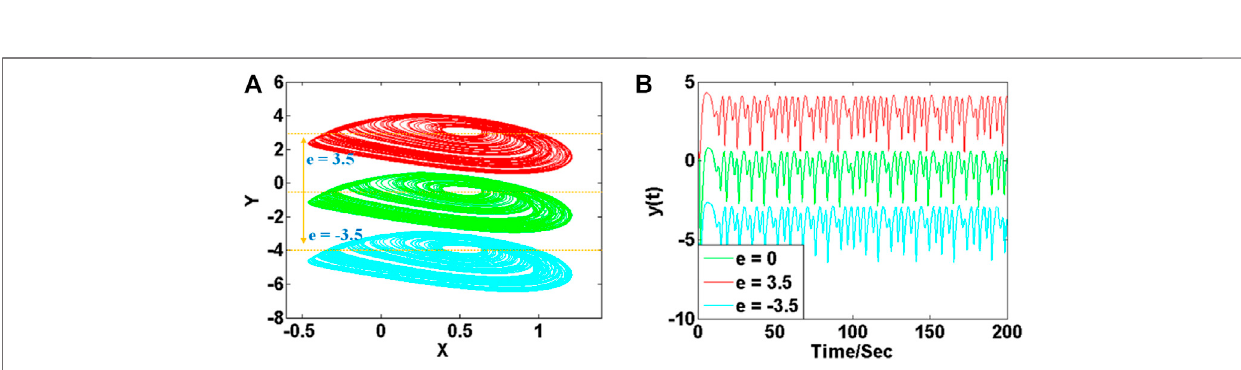
FIGURE14| Lyapunovexponentsandbifurcationofsystem(10)with a (cid:1) 2.8, b (cid:1) 5.5, c (cid:1) 1.7andtheinitialconditionsare(0,0,0)whenthememristorparameter d varies in [1.8, 3.8]. (A) bifurcation, (B) Lyapunov exponents.